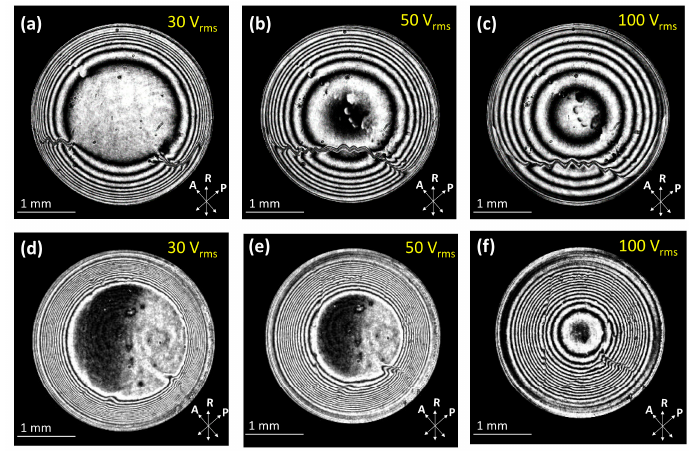
Figure 6. Comparisons of the interference patterns between the conventional LC lens and the TLCL lens. The interference patterns in ( a – c ) belong to the conventional LC lens without an insulator layer. The occurrence of a disclination line can be observed in the results. By contrast, the interference patterns in ( d – f ) belong to the TLCL lens when specially applying voltages, which show no disclination lines.